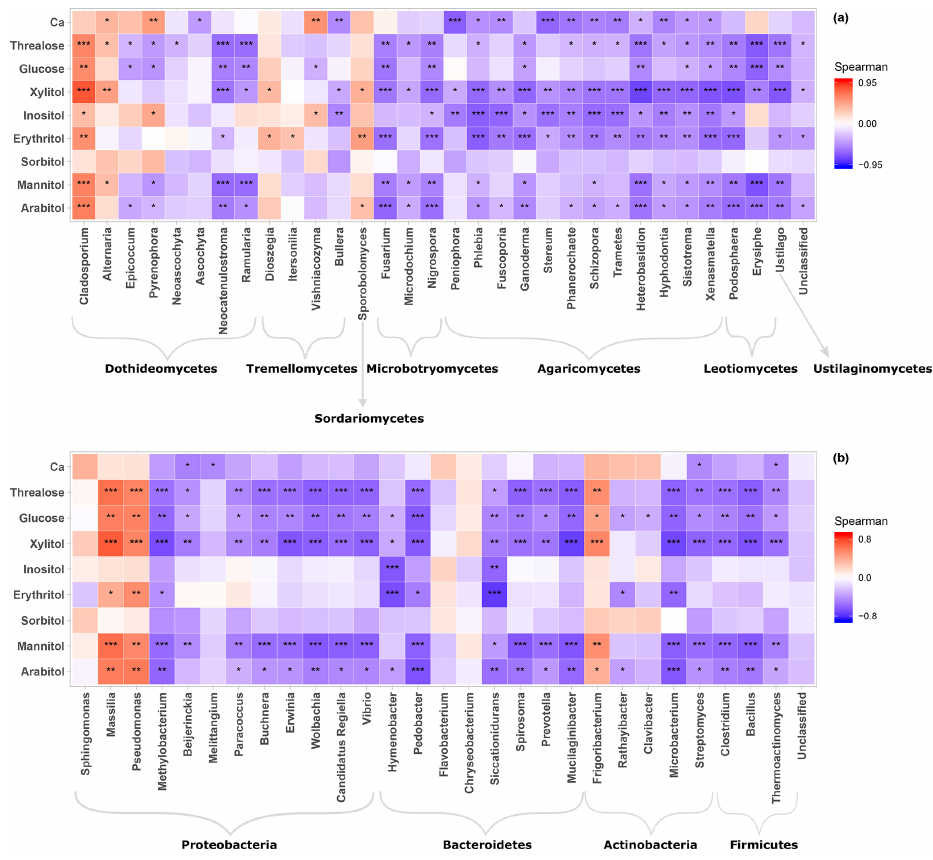
Figure 5. Heatmap of Spearman’s rank correlation between SCs and abundance of airborne communities at the study site. (a) Fungal genera and (b) bacterial genera. Only genera with relative abundance ≥ 1 are